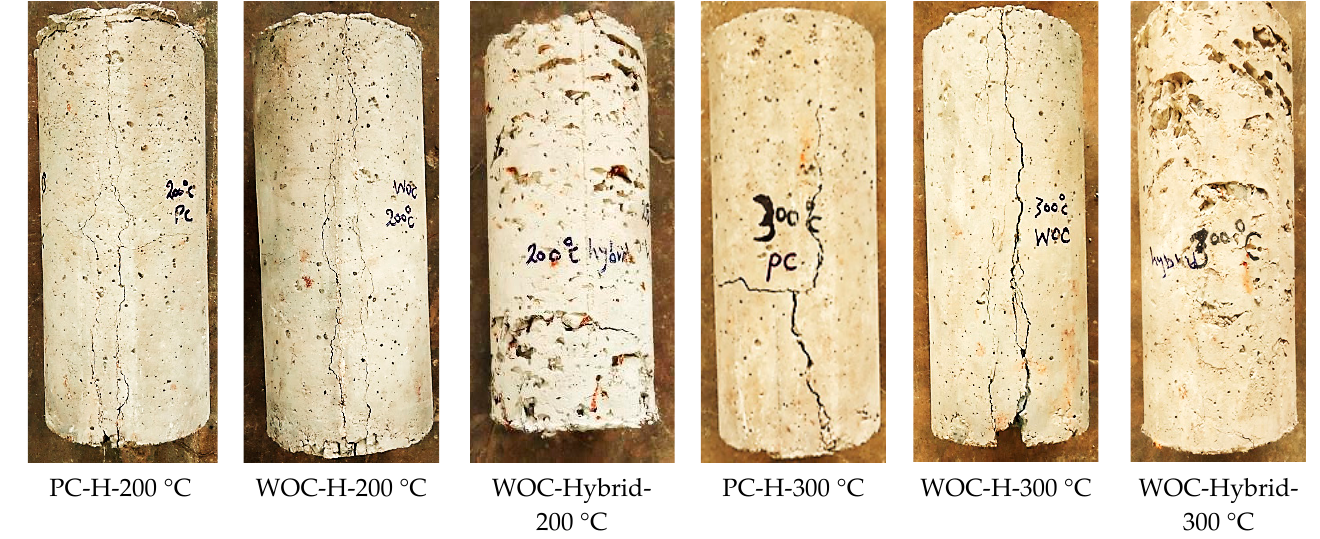
Figure 12. PC, WOC, and WOC-Hybrid cylinder at failure after exposure to elevated temperatures of 200 °C and 300 °C.